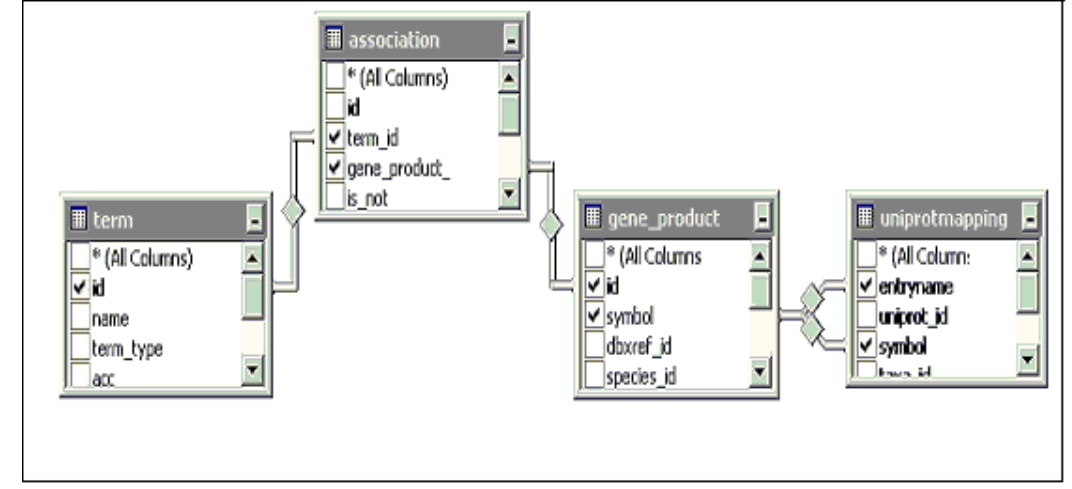
Figure 5. The database schema used for the Immune